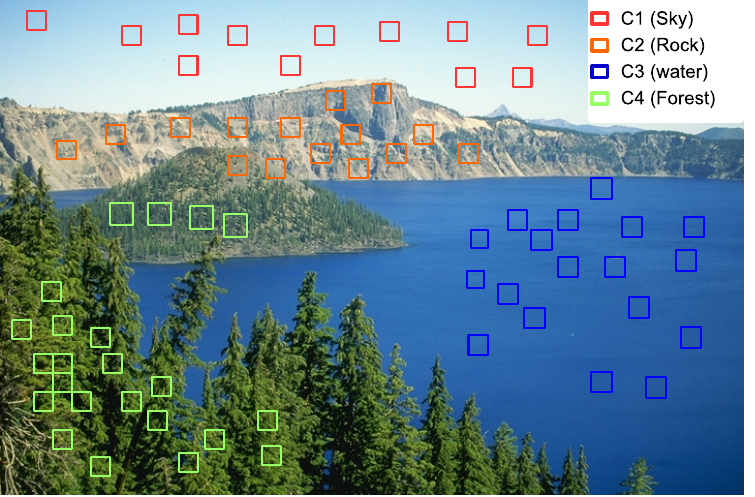
Figure 4. Textured zones example in a natural scene for k = 4 value in the k-means